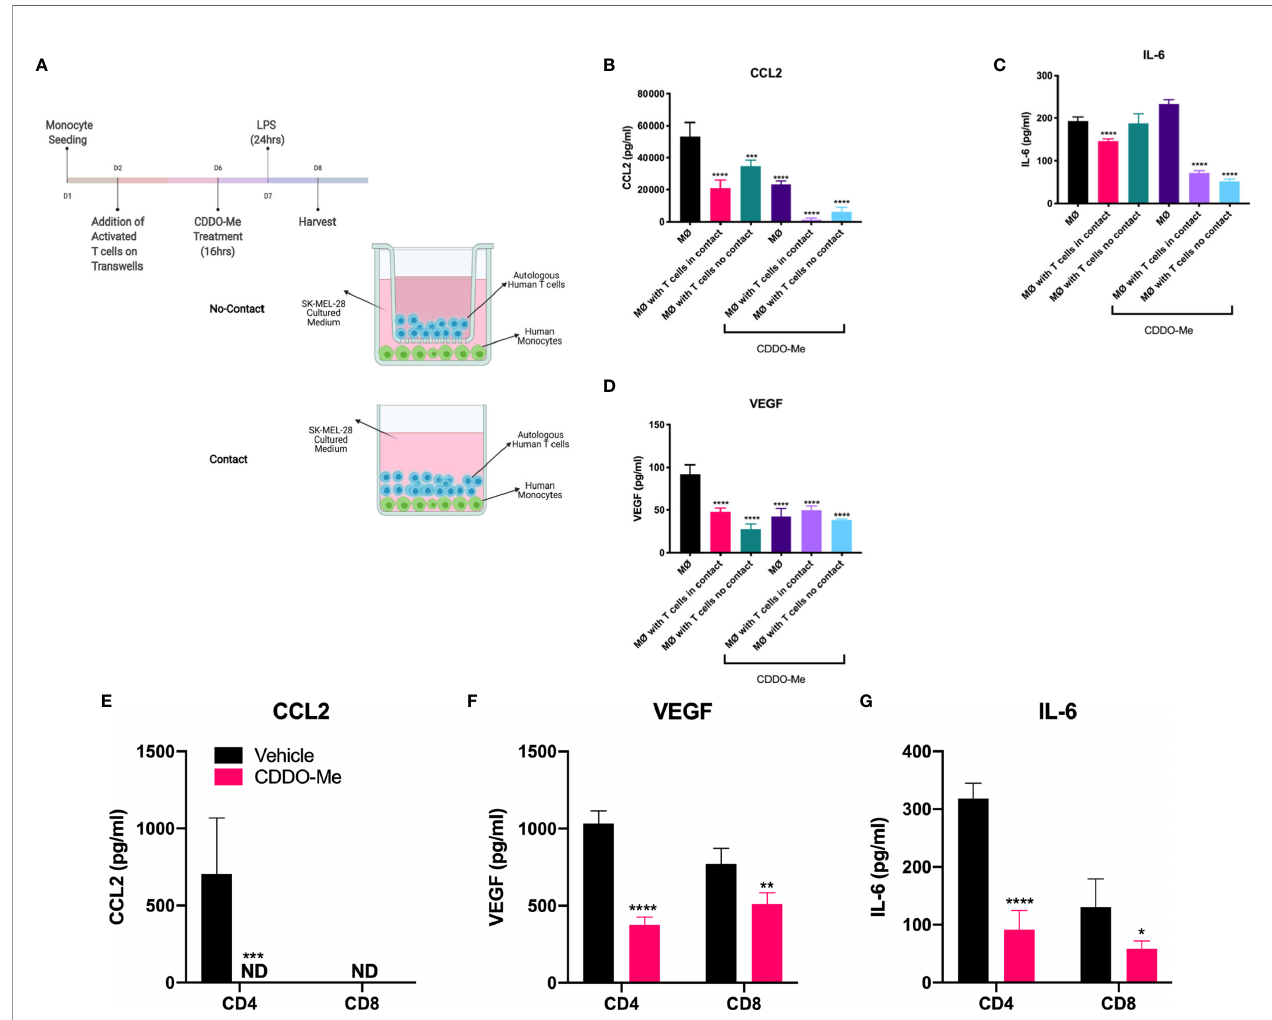
FIGURE 4 | T cell-mediated inhibition of human melanoma-conditioned macrophage cytokine production is contact-and T cell subset-independent. Human monocytes were differentiated with 20 ng/ml M-CSF alone (MØ) or with M-CSF and conditioned media from SK-MEL-28 cells and autologous T cells for 5 days with contact (no Transwells) or without contact (separated by Transwells) as depicted in (A) Cultures were then pre-treated with 300 nM CDDO-Me or DMSO (vehicle control) for 16 h, washed, and activated with LPS (10 ng/ml) for an additional 24 hrs. Culture supernatants were collected and cytokine context assayed using ELISAs for CCL2, IL-6, and VEGF (B – D) . Panels (E – G) show results of LPS-stimulated tri-cultures consisting of either CD4 or CD8 T cells, SK-MEL-28 cells, and MØs pretreated with or without CDDO-Me. Signi fi cance was analyzed in (B – D) using two-way unpaired T-test (CDDO-Me-treated vs. vehicle) and in (E – G) using two-way ANOVA (tri-cultures vs. MØ untreated control). *p < 0.05, **p < 0.01, ***p < 0.001,****p < 0.0001; not detected (ND). Data are representative of results obtained from analysis of 3 separate experiments from 3 individual donors. Two technical replicates were analyzed in three separate experiments. Error bars represent standard deviation